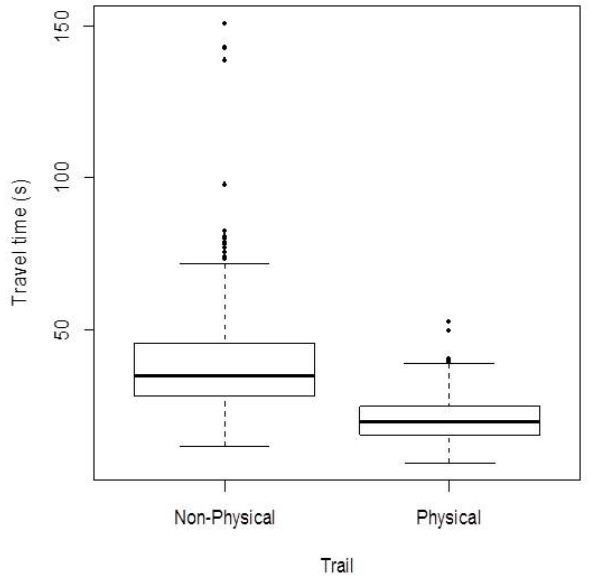
Fig 3. Relationship between travel time of forager workers and the two types of trails - physical and non-physical.